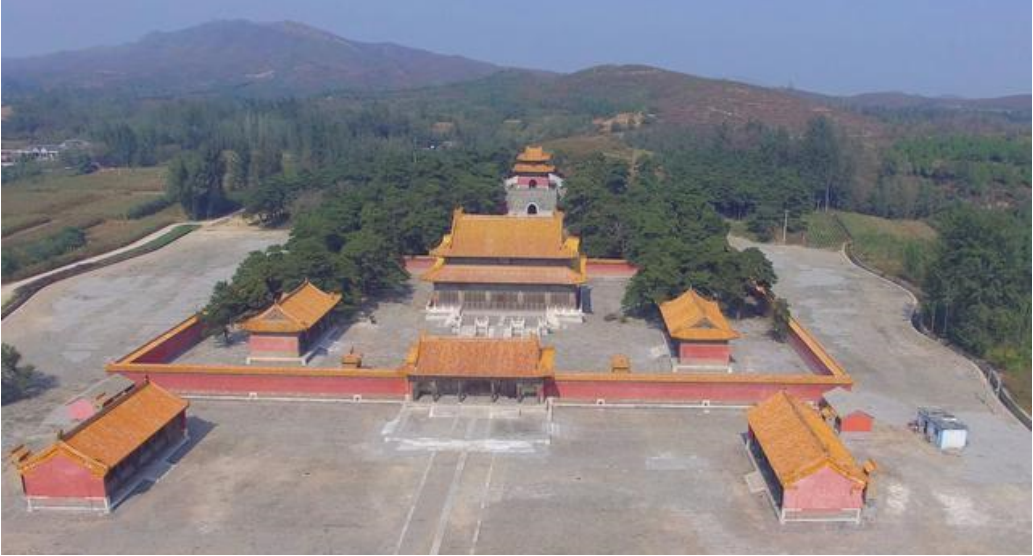
Figure 1. Panoramic photos of Taidong Tombs.